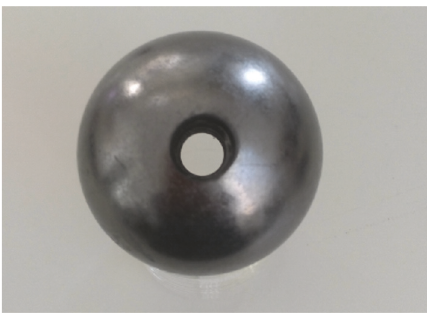
Figure 3: The graphite sphere with a penetrating hole after drilling.